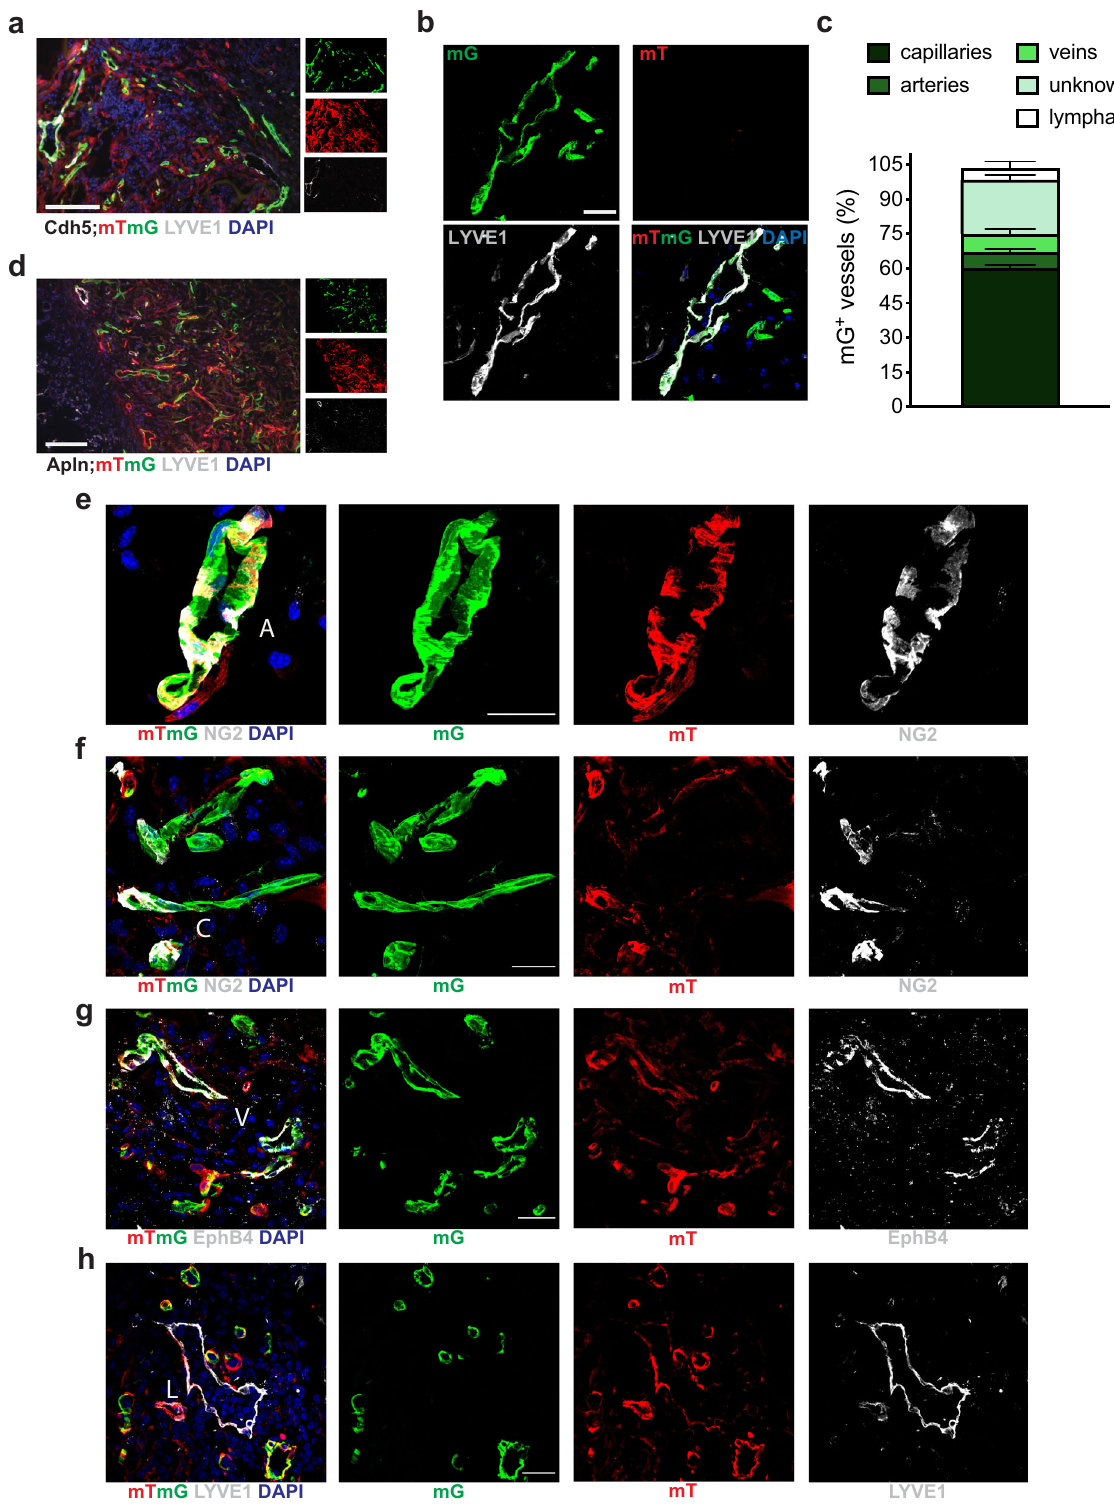
we observed using murine SVF, human SVF-derived ECs massively colonized the tissue underneath the scaffold and formed a dense, branched vascular network at day 7 after implantation (Fig. 5a). To discriminate between human and mouse ECs, we used species- speci fi c anti-CD31 antibodies and con fi rmed the presence